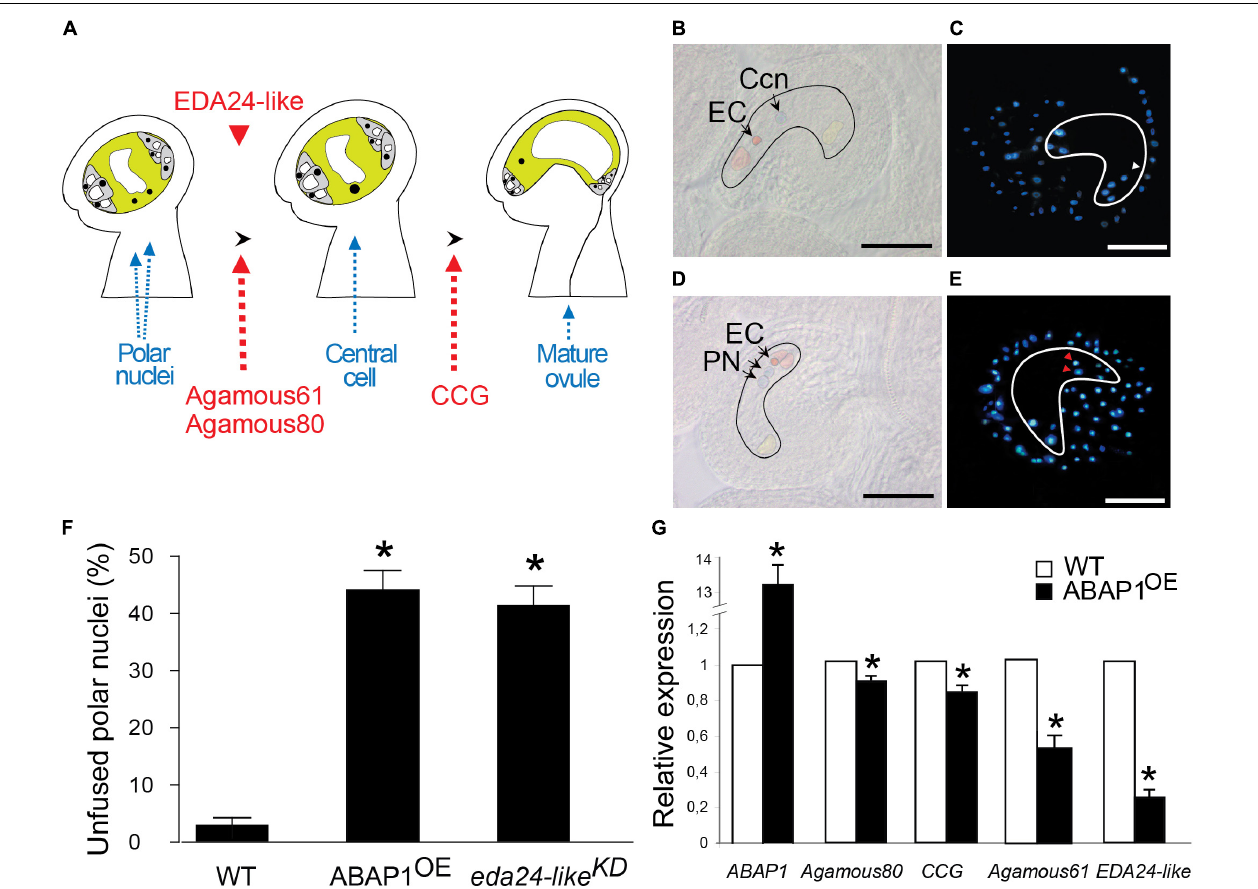
FIGURE 5 | Defective female gametophyte development in ABAP1 OE . (A) Schematic representation of the events taking place during maturation of the female gametophyte. The final embryo sac is a polarized structure with two main distinct regions: the micropyla and the chalaza. Red arrows indicate gene markers of embryo sac developmental stages. Red arrowhead represents the timing of EDA24-like expression. (B–E) Micrographs of wild-type and ABAP1 OE ovules. Embryo sacs and embryo sac cells were artificially outlined for better visualization. DIC microscopy (B) and DAPI staining (C) of wild-type ovules indicate the central cell nucleus (Ccn and white arrowhead) formed by fusion of the two polar nuclei. DIC microscopy (D) and DAPI staining (E) of ABAP1 OE ovules show two unfused polar nuclei (PN and red arrowheads). EC, egg cell; Ccn, central cell nucleus; PN, polar nuclei. Scale bars at (B–E) represent 20 µ m. (F) Percentage of unfused polar nuclei quantified in emasculated flowers at stage 13 (FG6-FG7) from wild-type Col, ABAP1 OE and eda24-like KD plants. For WT, 6 ovaries were analyzed, with a minimum of 25 and a maximum of 39 ovules analyzed per ovary. For ABAP1 OE , 14 ovaries were analyzed, with a minimum of 25 and a maximum of 36 ovules analyzed per ovary. For eda24-like KD , 8 ovaries were analyzed, with a minimum of 23 and a maximum of 34 ovules analyzed per ovary. A statistical analysis was performed by t -test ( p -value < 0.05). Asterisks (*) indicate significant changes. (G) Relative mRNA levels of ABAP1, Agamous 80 , CCG, Agamous 61 and EDA24-like were determined by qRT-PCR in wild-type and ABAP1 OE flower buds. Data were normalized with UBI14 as reference gene and were compared with wild-type. Each biological replicate was performed with a pool of 15 flower buds. Bars indicate mean ± standard error of biological replicates. A statistical analysis was performed by t -test ( p -value < 0.05). Asterisks (*) indicate significant changes.